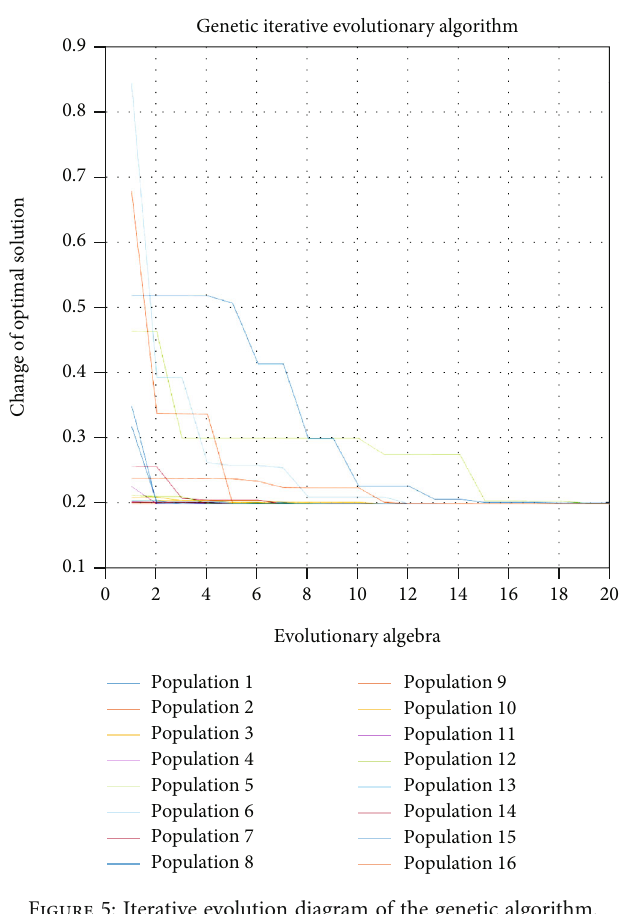
Figure 5: Iterative evolution diagram of the genetic algorithm.